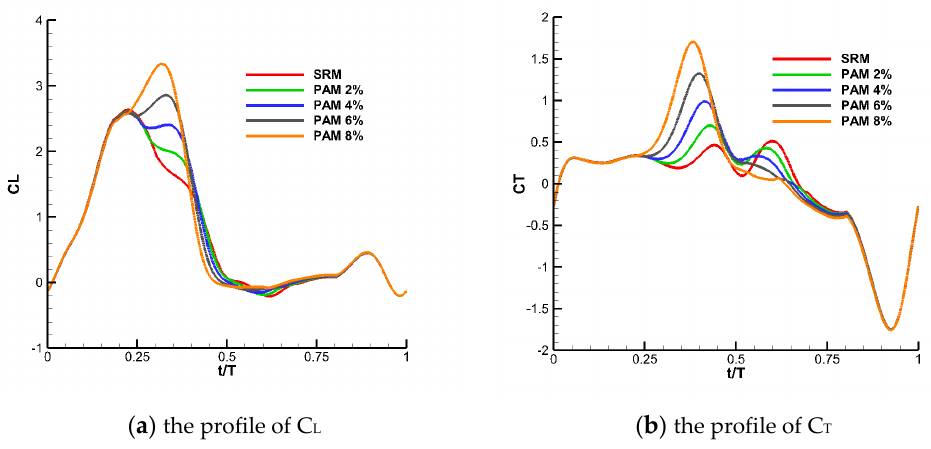
Figure 9. Time histories of C L and C T for PAM with di ff erent shift time